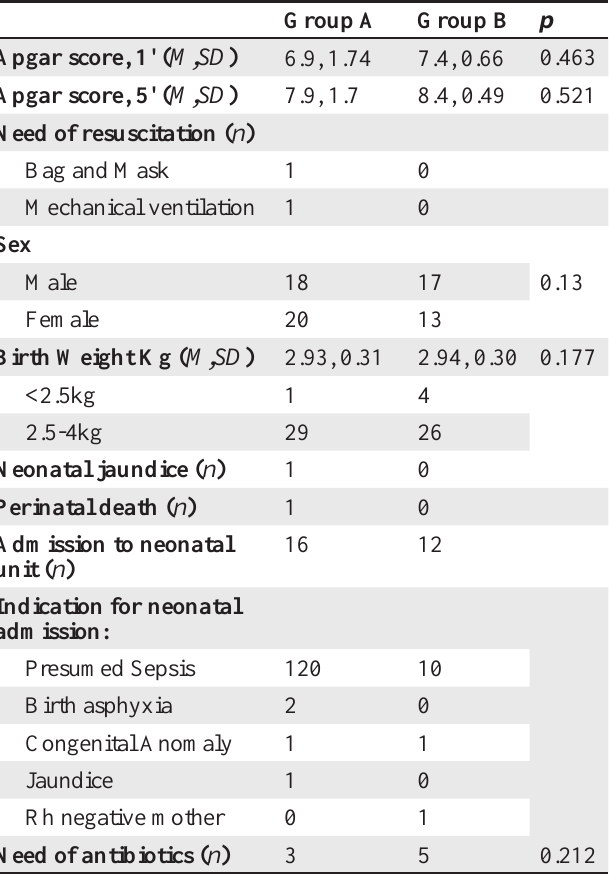
Table 5 : Distribution according to the neonatal